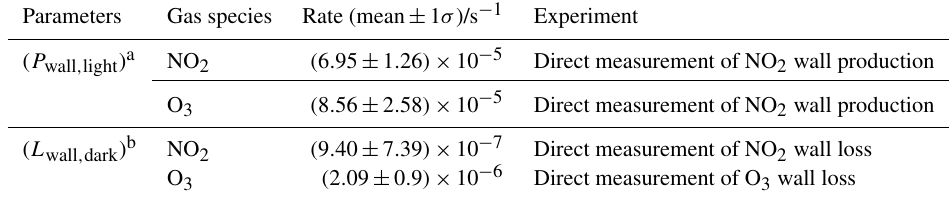
Figure 7. Measured and wall-loss-corrected SOA particle mass using two different wall loss correction approaches for a β -caryophyllene photo-oxidation (a) and a limonene ozonolysis (b) experiment. Table 3. Chamber wall activity and rates for chamber-dependent reactions. Parameters Gas